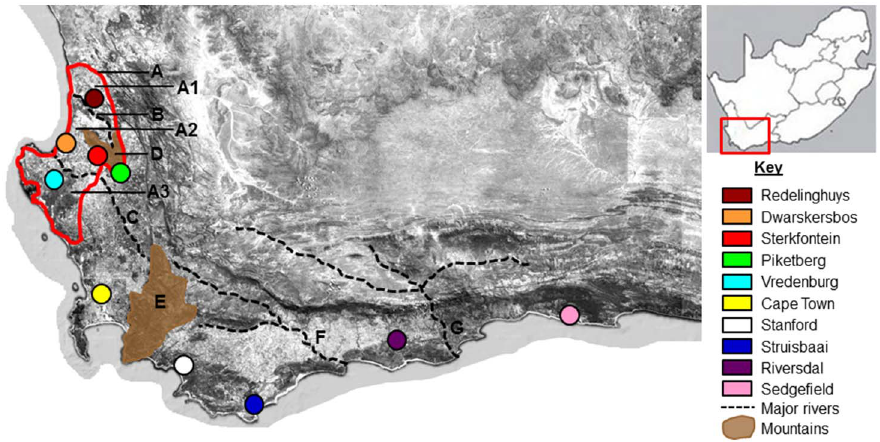
Figure 1. Sampling map of the 10 B.suillus populations in this study. Map showing the 10 B. suillus collection sites sampled across the Cape Floristic Region of South Africa. The geographic phenomena named in this study are A.) the Sandveld region with A1) the Redelinghuys, A2.) inner- Sandveld and A3.) Vredenburg areas, B.) the Verlorenvlei- and C.) Berg Rivers, D.) the Piketberg mountain, E.) the Hottentots Holland Mountains, F.) the Breede River and G.) the Gourits River. (The sampling map was adapted from ESRI (2007) ArcGIS version 9.3 Media Kit. Redlands, CA: Environmental Systems Research Institute).